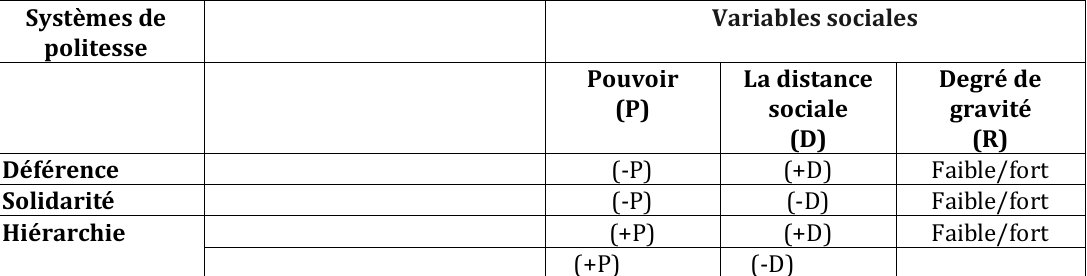
Tableu 1 Le système de politesse Scollon & Scollon